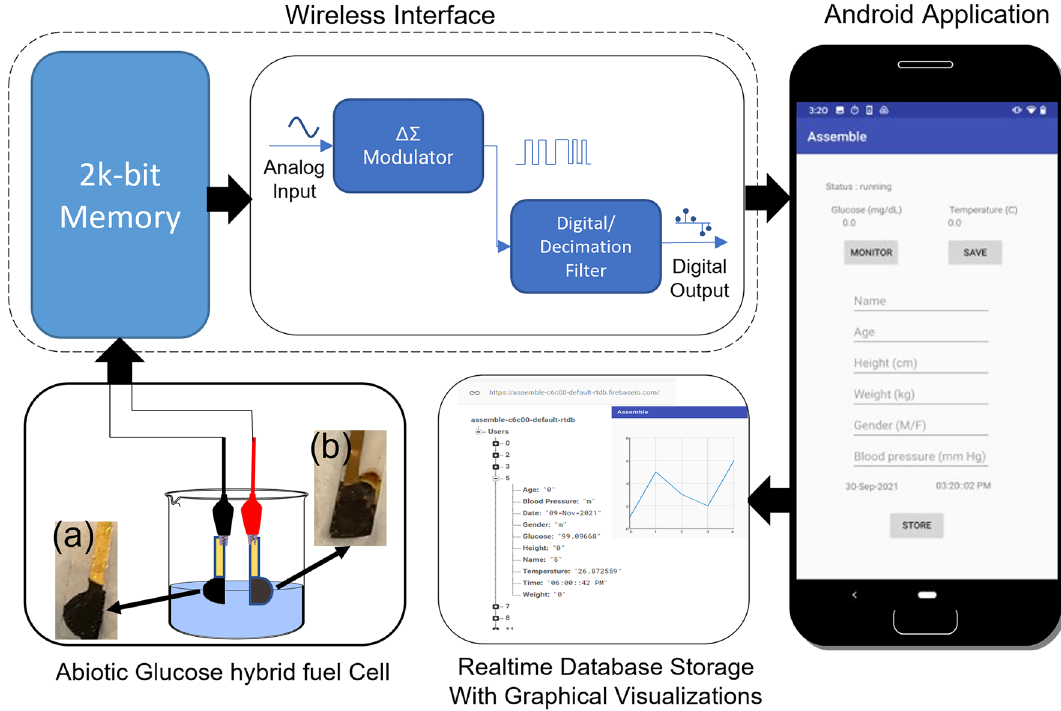
Figure 1. A schematic illustration of the wireless glucose monitoring system comprising an abiotic glucose hybrid fuel cell, an NFC module, and a smartphone application. The abiotic glucose hybrid fuel cell is constructed using colloidal platinum (co–Pt) anode ( a ) and silver oxide (Ag 2 O) nanoparticles-carbon nanotubes (MWCNTs) cathode ( b